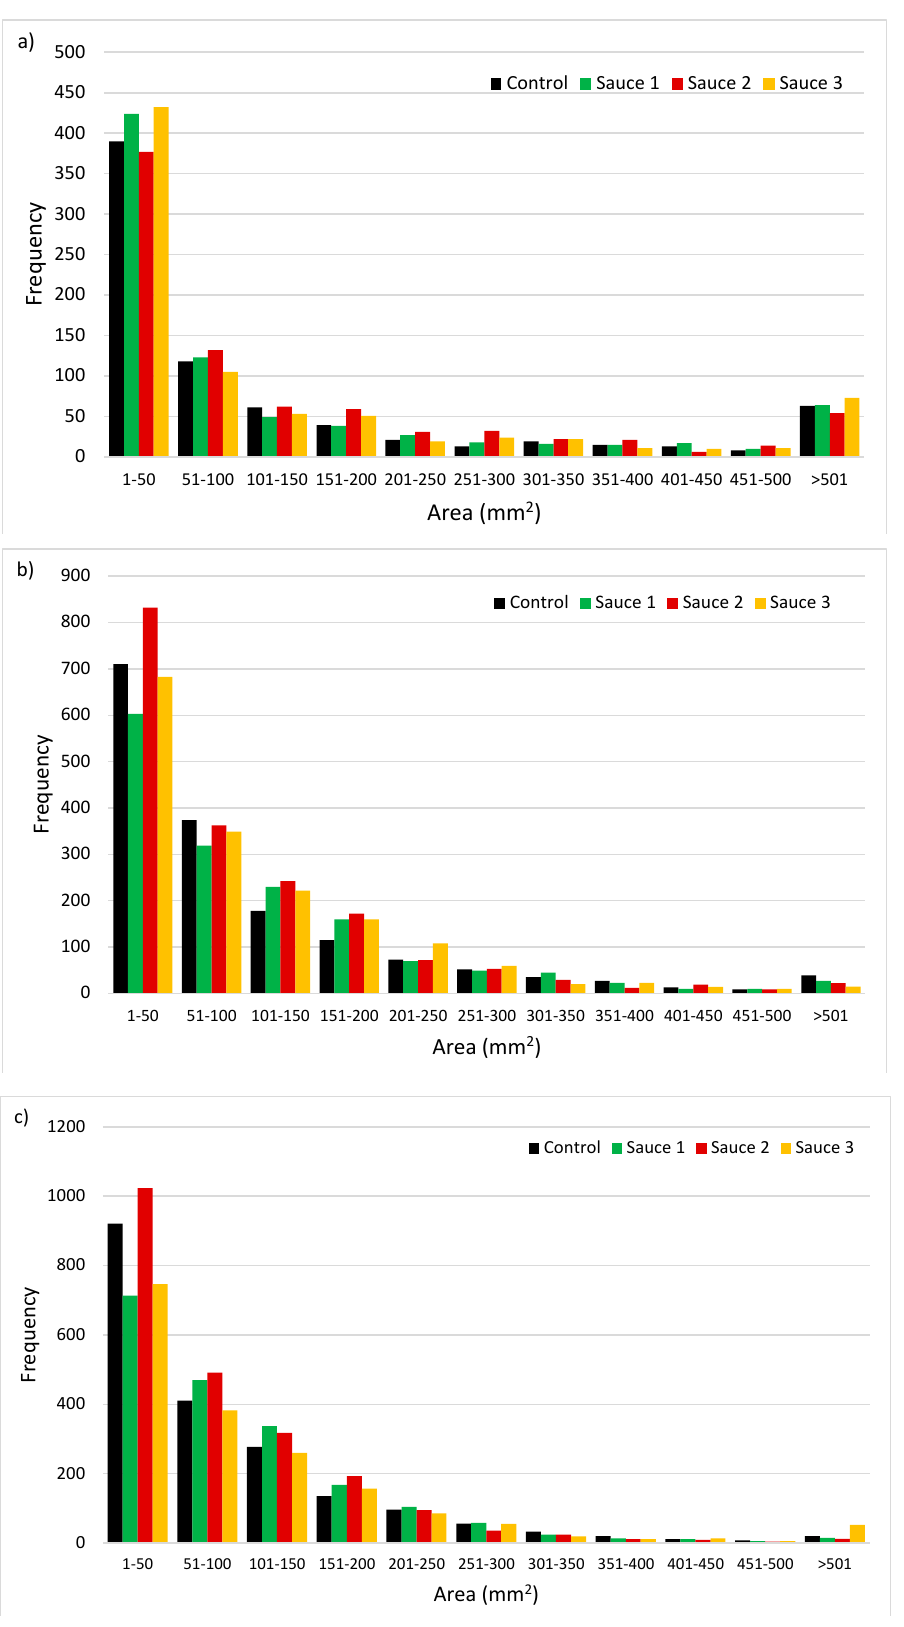
Figure 2. Particle size distribution (frequency vs. area): ( a ) after 10 strokes; ( b ) after 25 strokes; ( c ) before swallowing.